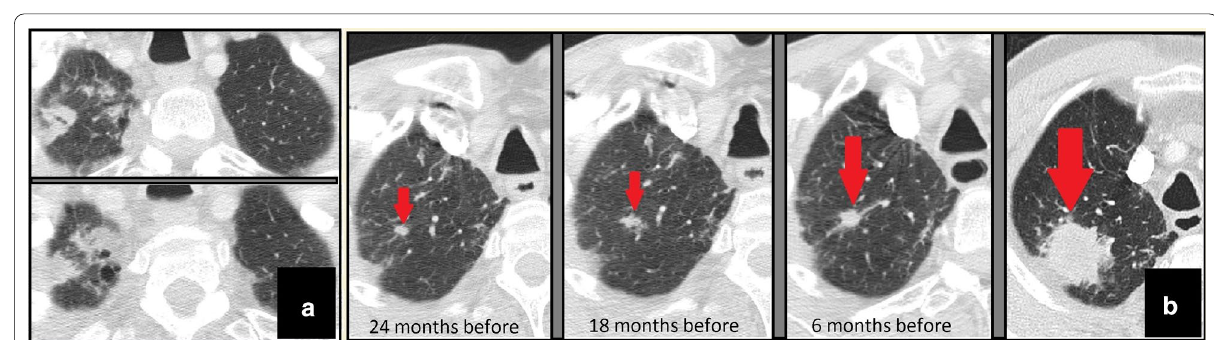
Fig. 10 Prior examination (type 7) and satisfaction of report (type 12) errors. Follow-up images of a male patient with a history of larynx cancer showed that both lung apices were within the imaging field in all the control neck CTs. More prominently in the right apex, bilateral apical fibrotic changes were present and consistently reported ( a ). Due to reliance on previous reports, apical areas were not evaluated carefully. Consequently, a nodular lesion showing a gradual increase in size, located within right apical fibrotic changes, was repeatedly missed until it reached large dimensions (red arrows, b ). Percutaneous biopsy and subsequent histopathological examination confirmed the diagnosis of primary lung